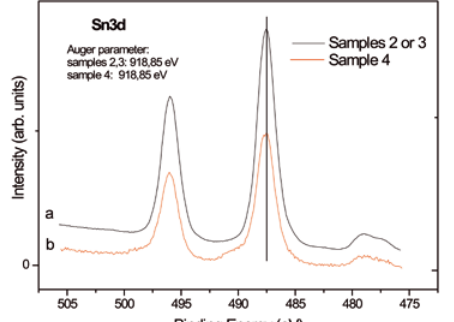
Figure 6. XRD profiles at different incidence angle φ = 0.4º to 3º of Sample 3